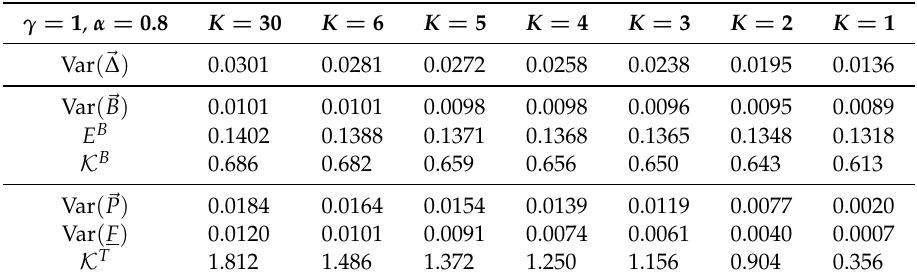
Table 1. Various infrastructure measures as a function of the truncation parameter K used for the PCA approximation